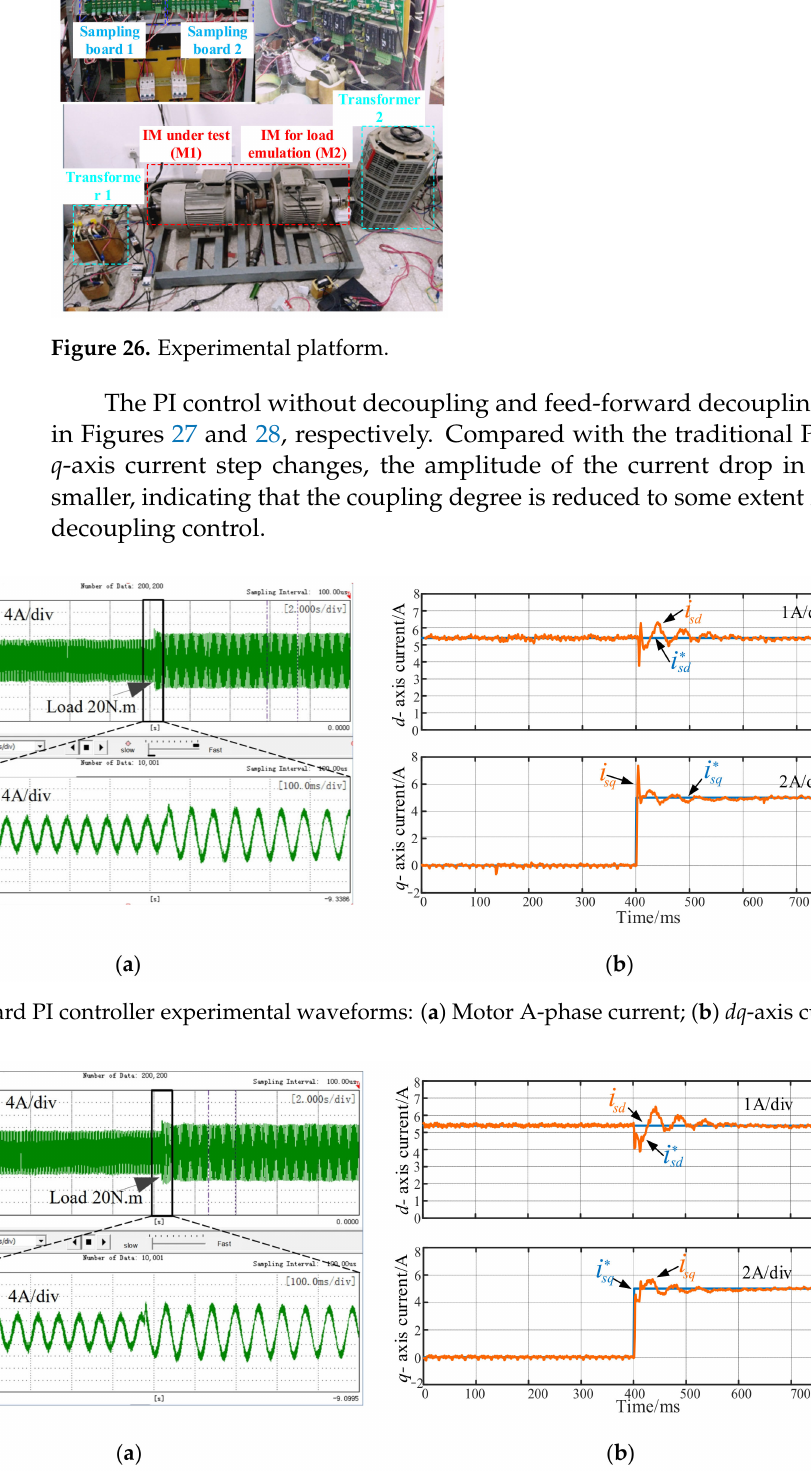
Figure 28. Feed-back PI controller experimental waveforms: ( a ) A-phase stator current; ( b ) dq -axis current